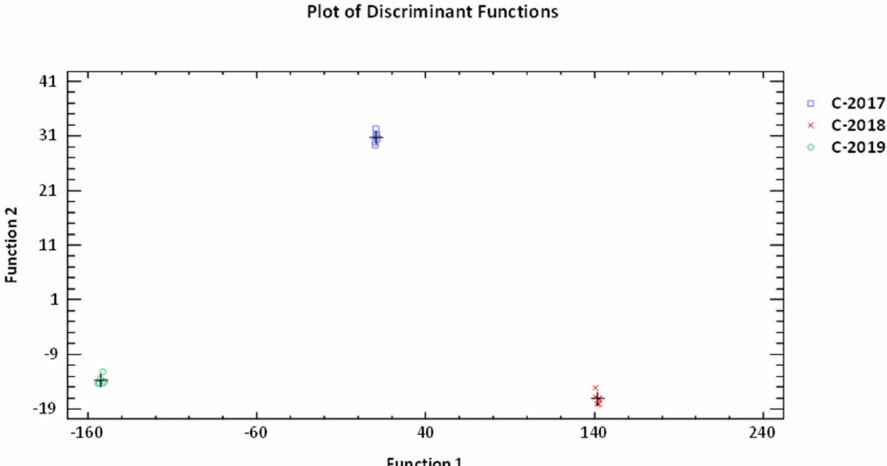
Figure 3. Plot showing discriminant functions of ‘Mansa de Figueiredo’ EVOOs according to crop year based on the concentration of 12 individual phenolic compounds (Function 1 vs. Function 2). C-2017: EVOOs from 2017 campaign; C-2018: EVOOs from 2018 campaign; C-2019: EVOOs from 2019